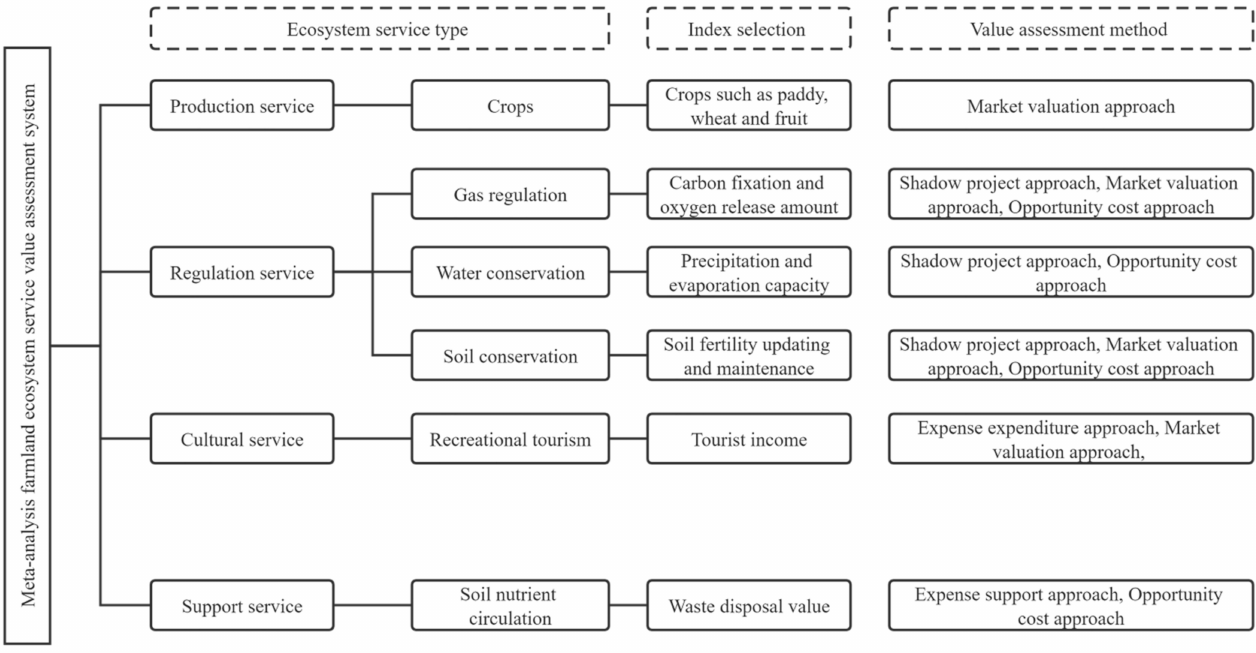
Figure 1. Meta-analysis farmland ecosystem service value assessment